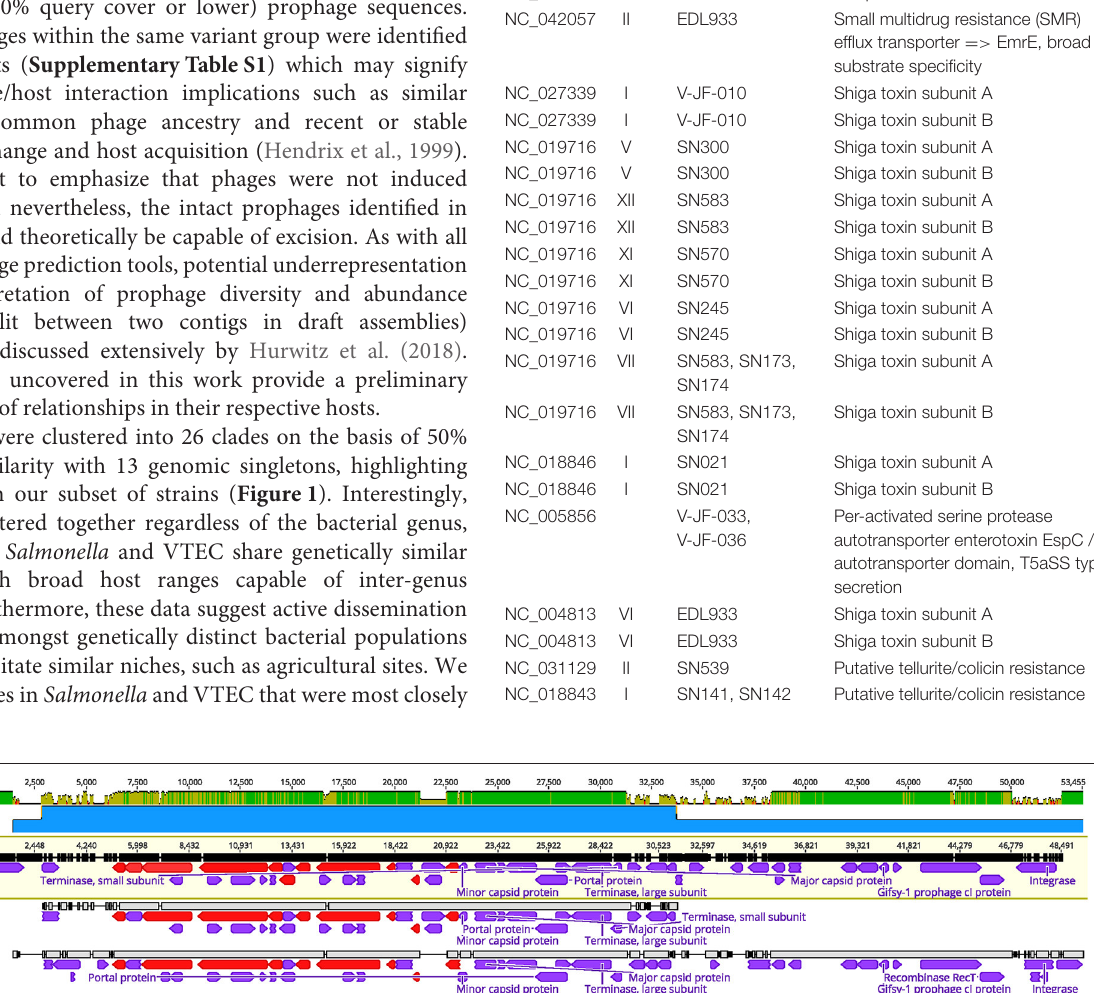
Frontiers in Microbiology |